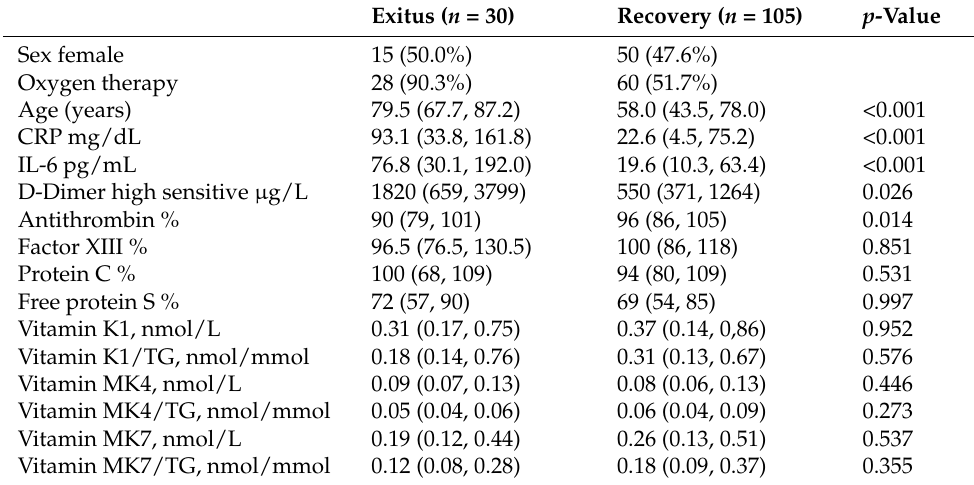
Table 1. Baseline characteristics of COVID-19 patients.